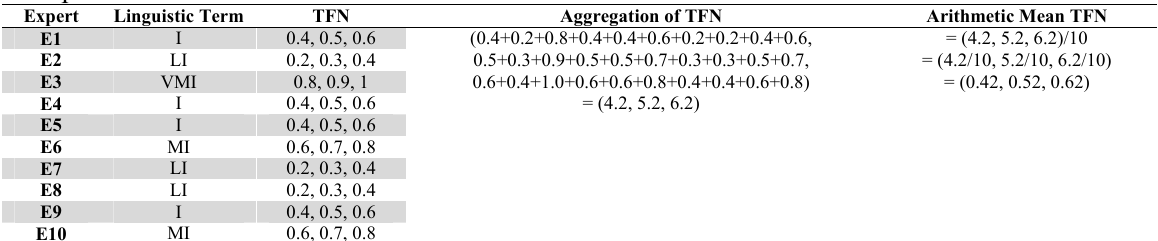
Crisp value calculation Expert Linguistic